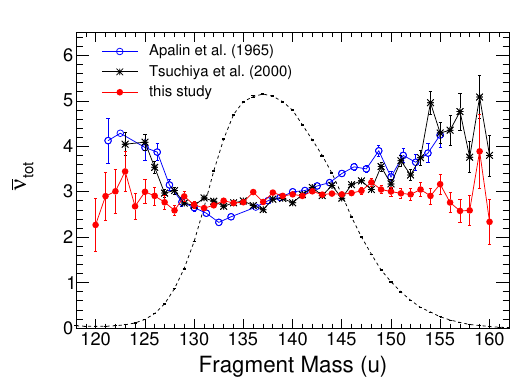
Figure 2. Average prompt neutron multiplicity per fission as a function of the fragment TKE. Data obtained in this study is com- Figure 1. Fluctuations in the average neutron multiplicity as a pared to data from Tsuchiya et al. [17]. The dotted black line function of the incident neutron energy in 239 Pu(n,f). Experi- shows the shape of the fission fragment TKE distribution (with- mental data from Refs. [1–3]. out absolute scale). The full black line represent a least square fit of a straight line to the data from this study with an inverse slope ∂ν/∂ TKE - = 11.4 MeV / n. −